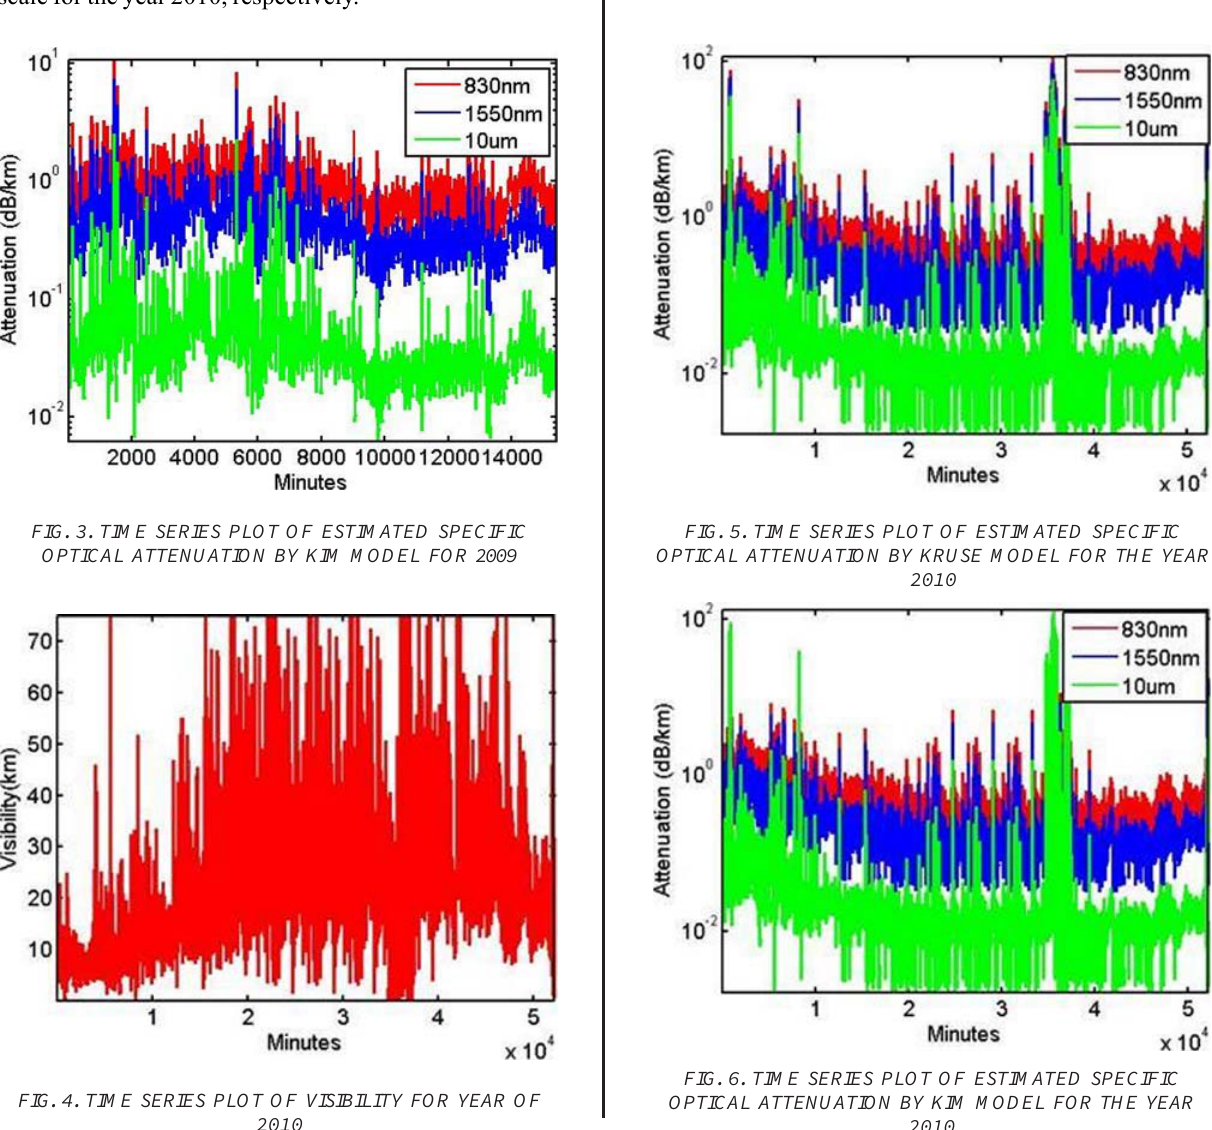
FIG. 6. TIME SERIES PLOT OF ESTIMATED SPECIFIC OPTICAL ATTENUATION BY KIM MODEL FOR THE